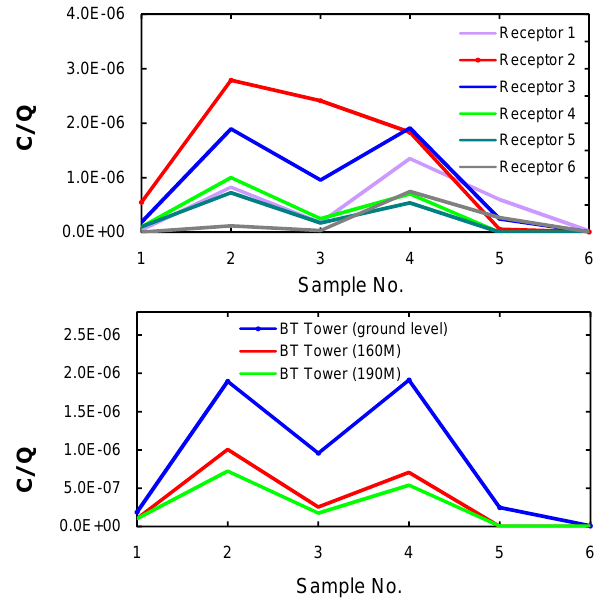
Fig. 3. Time series of concentrations for REPARTEE I. The top panel shows the averaged 9min values at all off the receptors while the bottom panel shows an expanded representation of the values from the BT